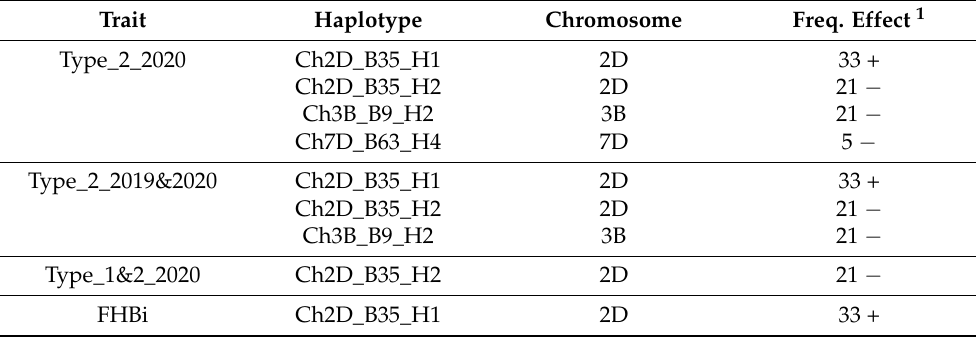
Table 3. Haplotypes described by GWAS and their effects on FHB related traits.